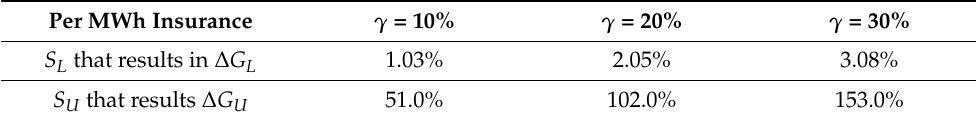
Table 1. Percentage changes in G by per MWh insurance premium and insured amount γ . Per MWh Insurance γ = 10% γ = 20% γ = 30% S L that results in ∆ G L 1.03% 2.05% 3.08% S U that results ∆ G U 51.0% 102.0%